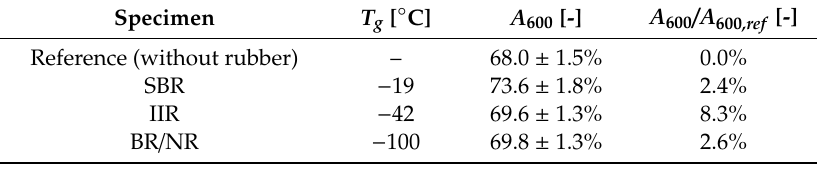
Figure 9. Dependency between absorption parameter A and impact velocity v 0 for different armor configurations.